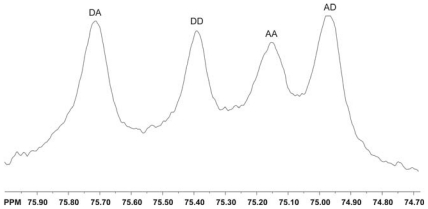
Sections of the 13C NMR spectra of chitosan; DA = 48, showing the C-5 signals region. Spectrum was recorded at 100 MHz and 70 °C in D2O (pD ~ 5) relative to internal acetone (δC 31.45). Appropriate sequences are labeled.